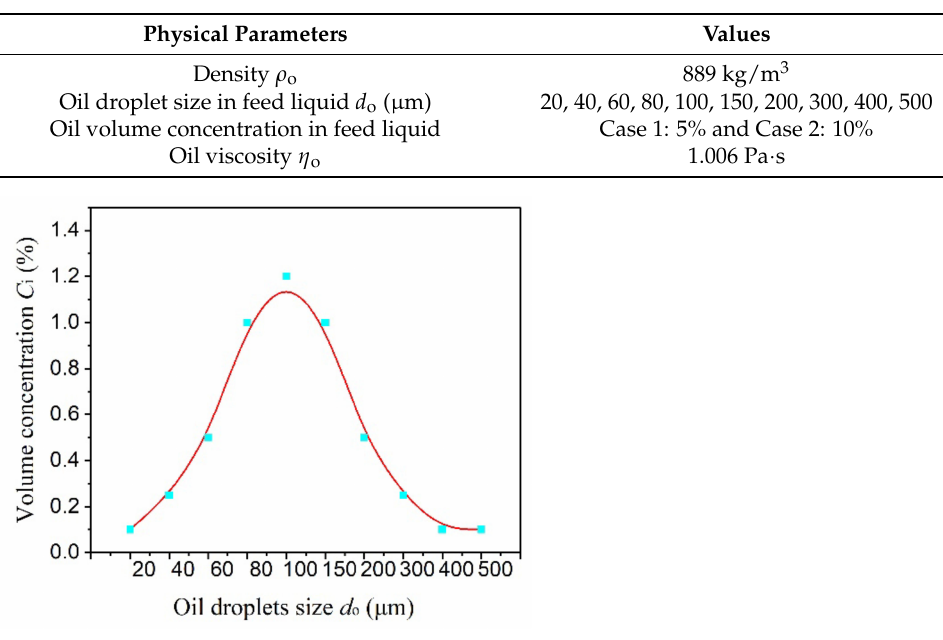
Table 2. Physical parameters of oil phase.